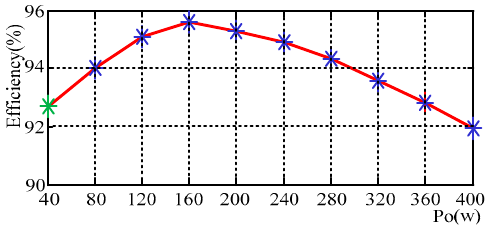
Figure 8. Test efficiency of prototype.